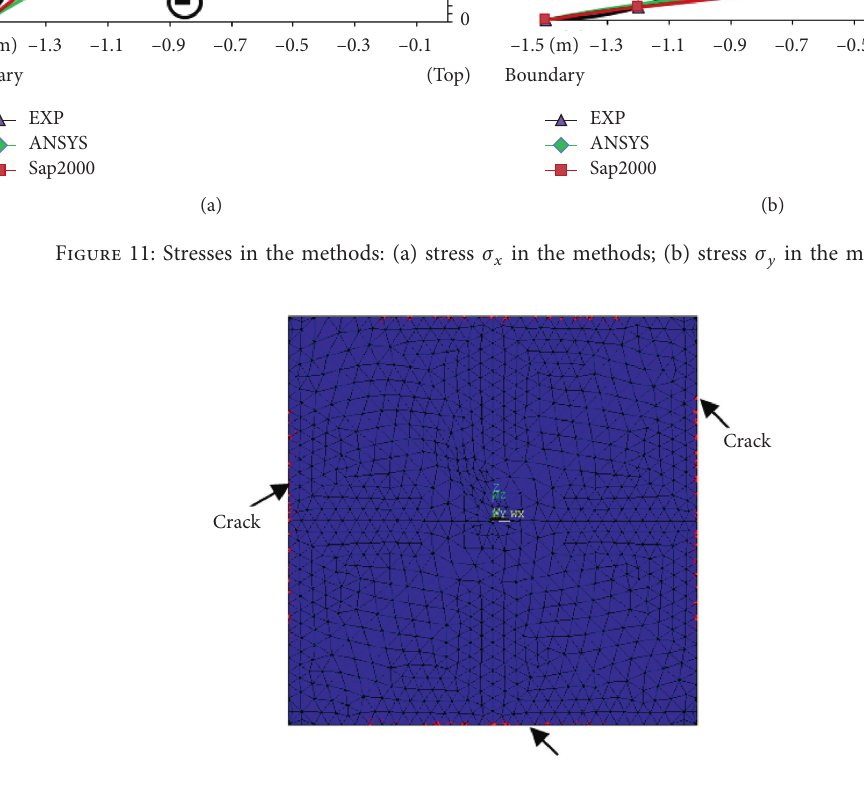
Figure 12: Location of cracks in shell (Case